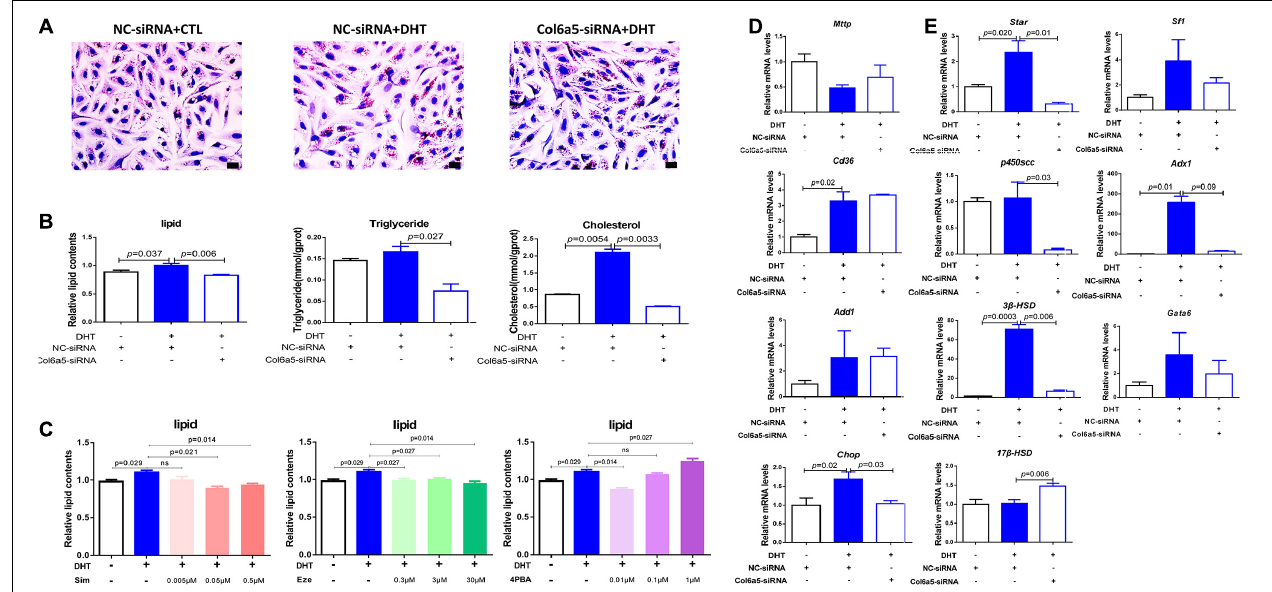
FIGURE 4 | Col6a5 -siRNA alleviated excess lipid accumulation in DHT-treated ovarian stromal cells. (A) Oil Red O staining of ovarian stromal cells; n = 3, Scale bars = 20 µ m, NC-siRNA, negative control siRNA; Col6a5 -siRNA, targeted Col6a5 mRNA siRNA. Cells were cultured in medium with 1 µ M DHT for 24 h. siRNA transfection was completed before DHT treatment. (B) Quantification of lipid, triglyceride and cholesterol levels in stromal cells. The lipid concentrations were calculated relative to the total protein concentration; n = 3. The data are expressed as the mean ± SEM and were compared by Mann-Whitney U -test. (C) Process-specific inhibition of cholesterol metabolism and relative quantification of lipid concentration in stromal cells. Simvastatin (Sim), an inhibitor of cholesterol synthesis; ezetimibe (Eze), an inhibitor of cholesterol uptake; and 4-PBA, an inhibitor of endoplasmic reticulum stress; n = 3. The data are expressed as the mean ± SEM and were compared by Mann-Whitney U -test. (D) Relative expression of lipid metabolism-related genes in stromal cells from each treatment group; n = 3. The data are expressed as the mean ± SEM and were compared by Mann-Whitney U -test. (E) Relative expression of cholesterol metabolism-related genes in interstitial cells from each treatment group; n = 3. The data are expressed as the mean ± SEM and were compared by Mann-Whitney U